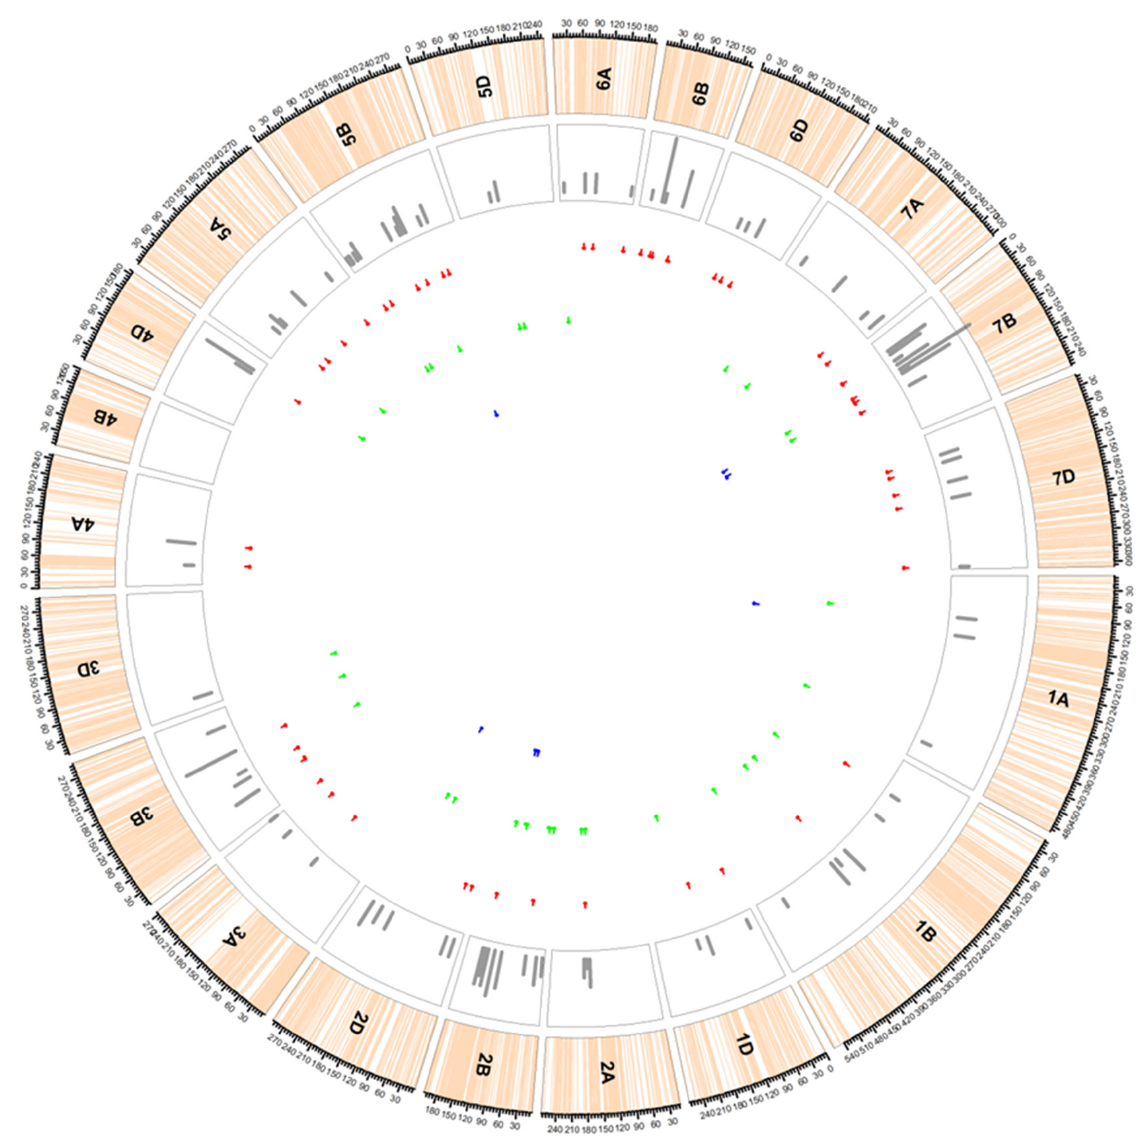
Figure 7. Distribution of leaf rust (red lines), yellow rust (green lines), and leaf/yellow rust (blue lines in the inner circle) QTLs. Light-brown lines in the outer track indicate the marker positions on each chromosome; grey bars in the second circle indicate the number of markers confined to each QTL. The red, green, and/or blue lines under the track circle indicate the span of QTLs, with small vertical lines point to the peak position of QTL. See Table S3 for details.